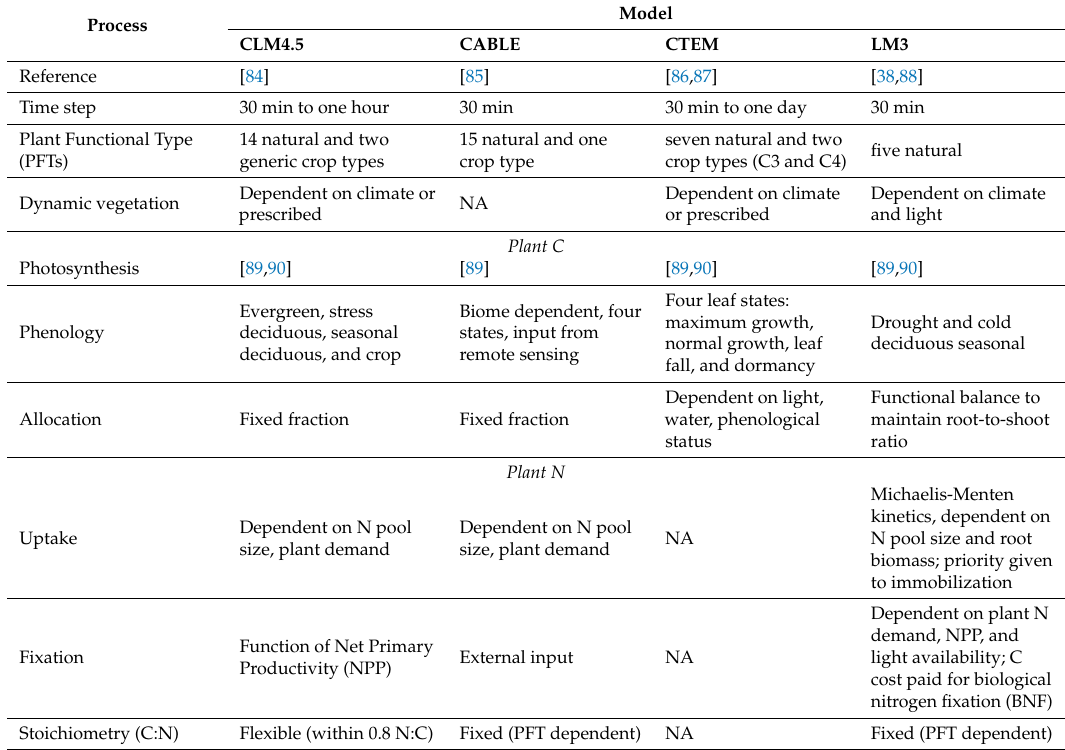
Table 1. Representation of key model features from a subset of terrestrial ecosystem